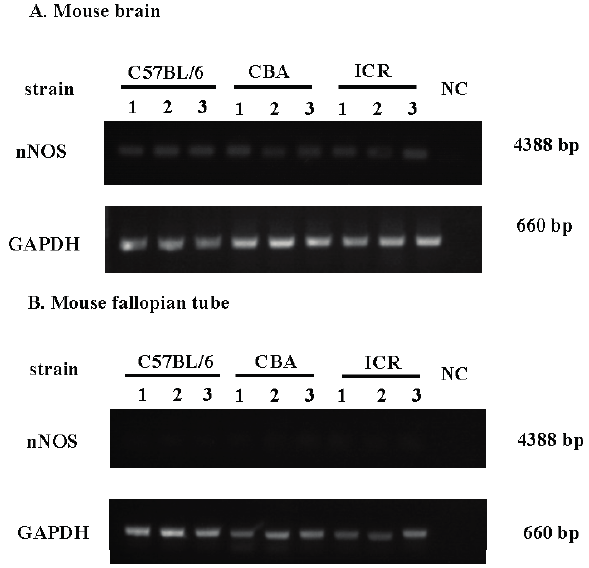
Figure 1. RT-PCR of neuro nitric oxide synthase (nNOS) in mouse brains and